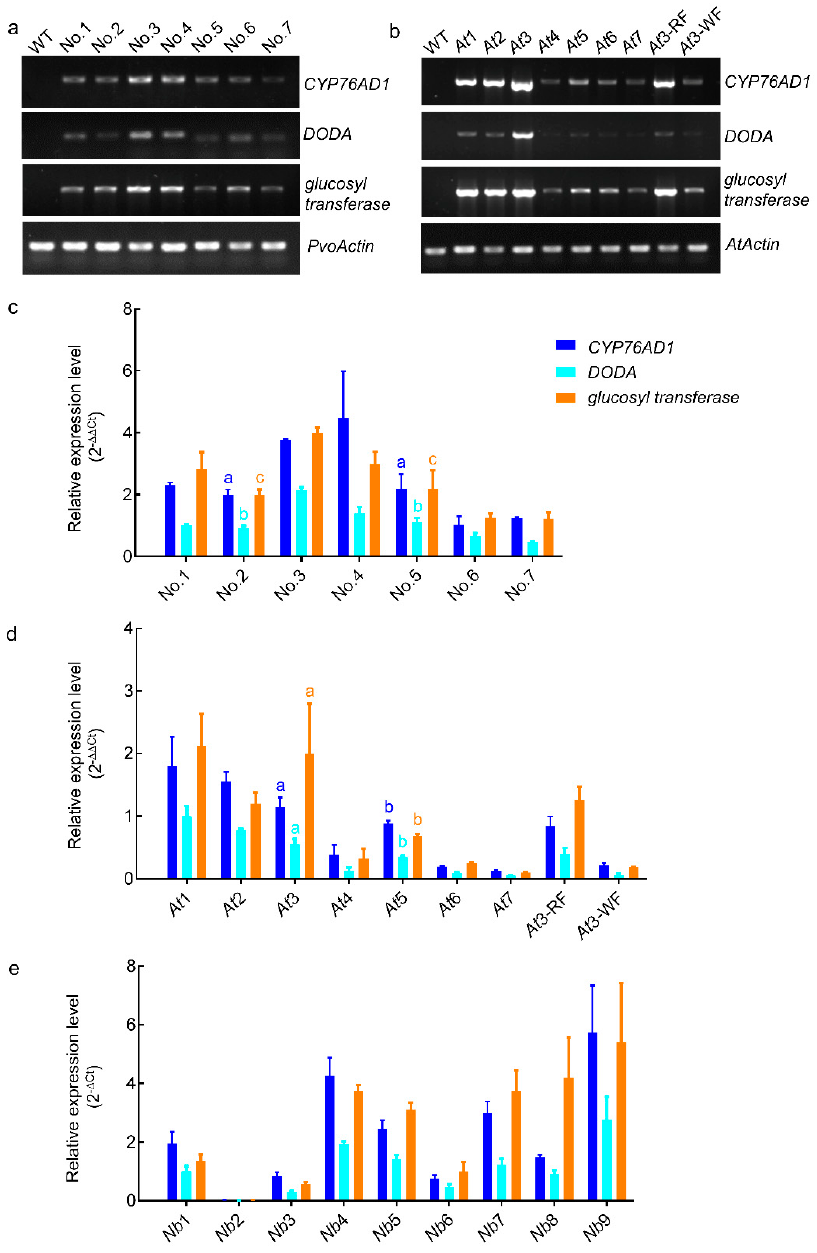
Figure 5. The expression analysis of CYP76AD1 , DODA , and glucosyl transferase in transgenic hairy roots and plants. ( a ) RT − PCR detection of the expression of three genes in different regions of RUBY transgenic hairy root of P. volubilis . No. 1 − 7 are different regions of RUBY transgenic of P. volubilis hairy roots, and WT is the wild-type root. ( b ) RT − PCR detection of the expression of three genes in RUBY transgenic Arabidopsis . At 1 − At 3 are fully colored lines, and At 4 − At 7 are noncolored lines. At 3 − RF and At 3 − WF were red inflorescence and white inflorescence of line #3, respectively. ( c – e ) RT − PCR detection of three gene expression levels in RUBY transgenic hairy roots of P. volubilis ( c ) and N. benthamiana ( e ), and RUBY transgenic Arabidopsis lines #1–#7 and red and white inflorescence in line #3 ( d ). Vertical bars indicate standard errors of means ( n = 3), different letters indicate significant differences at p < 0.05 (Fisher’s LSD test) between the corresponding values of “No.2” and “No.5”and “ At 3” and “ At 5”,